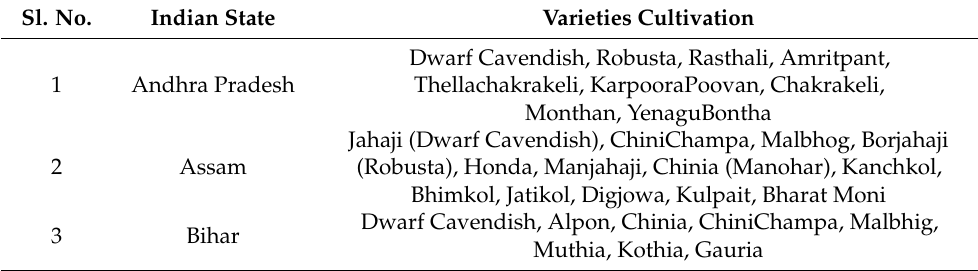
Table 1. Distribution of banana cultivar varieties in Indian states. Adopted and modified from the Database of National Horticulture Board, Ministry of Agriculture, Govt. of India (http://nhb.gov.in/ report_files/banana/BANANA.htm accessed on 22 December